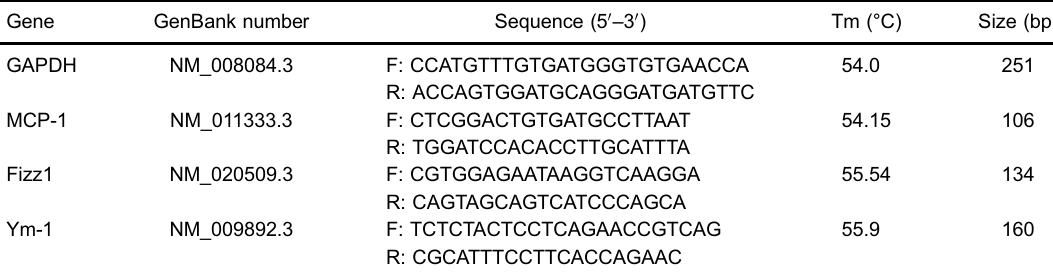
Table 1. Primer sequences for real-time PCR analysis.